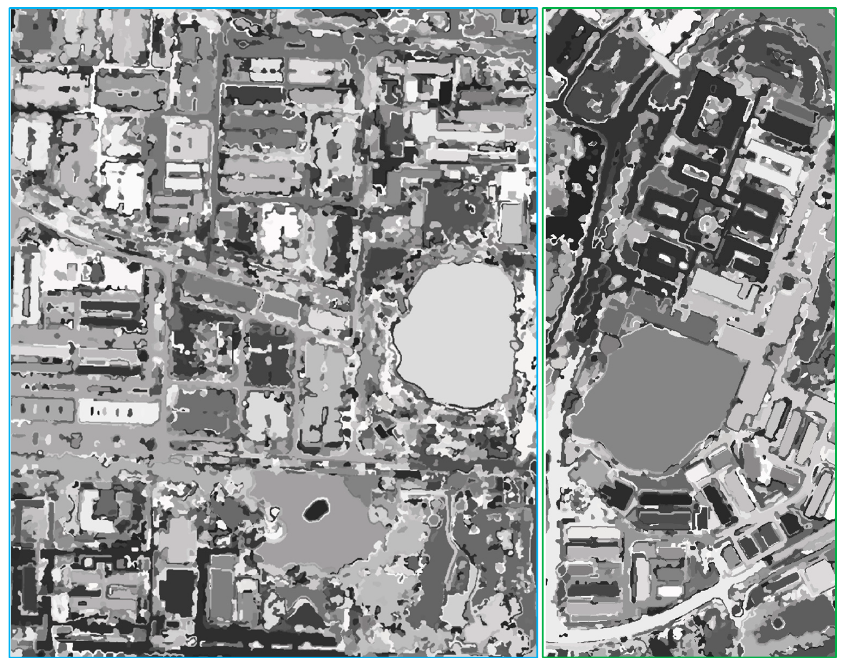
Figure 5. The results of MRS segmentation with optimal parameters were found by the proposed Bayesian optimization method for the ( left ) training and ( right ) test